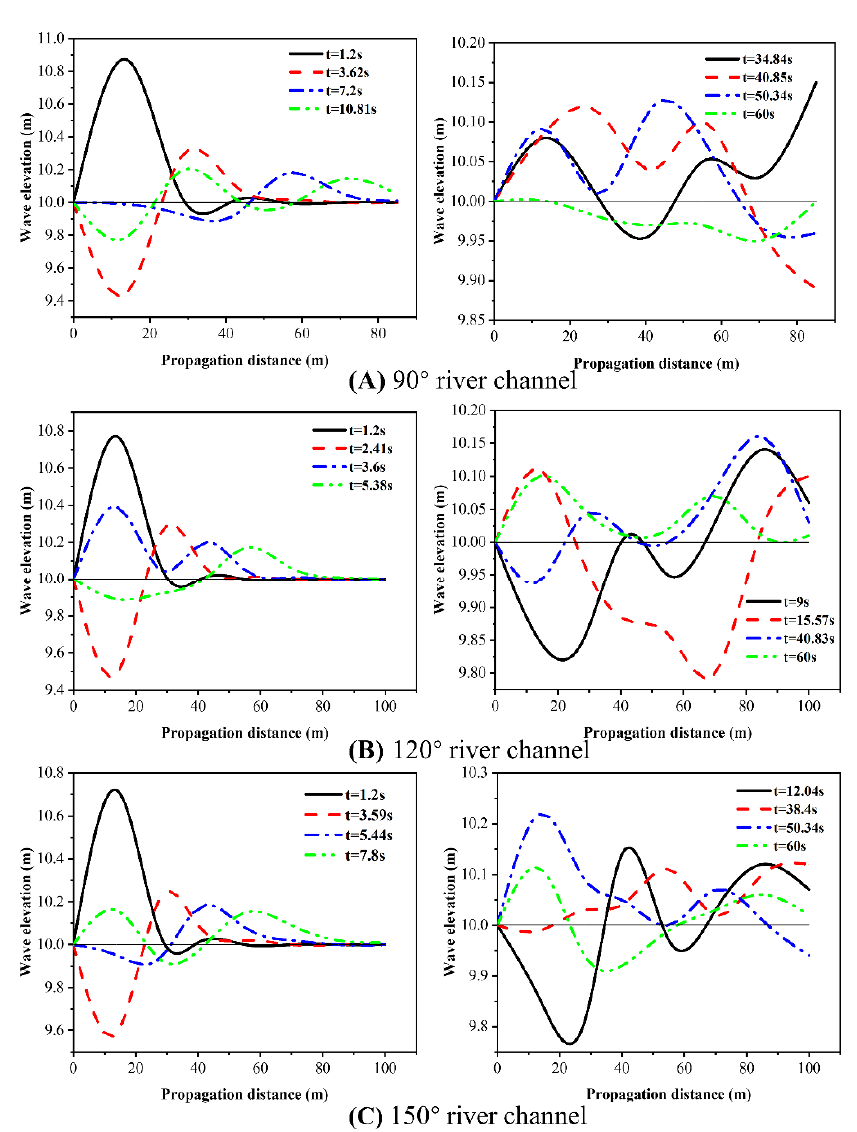
Figure 9. Wave variation at different times in the curved channel with different bending angles.